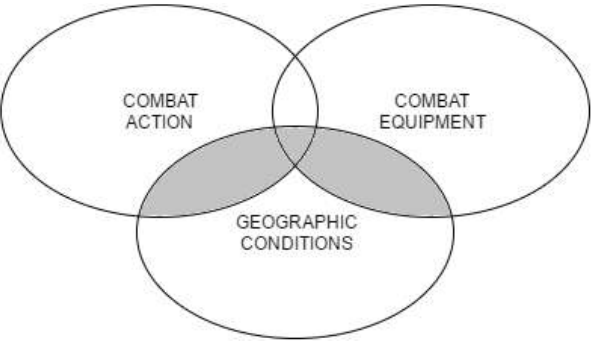
Fig. 1: The influence of geographic conditions to combat action and combat equipment